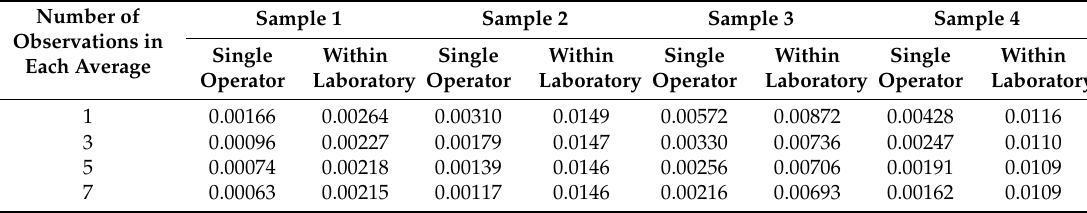
Table 10. Critical differences of static friction index for friction properties.